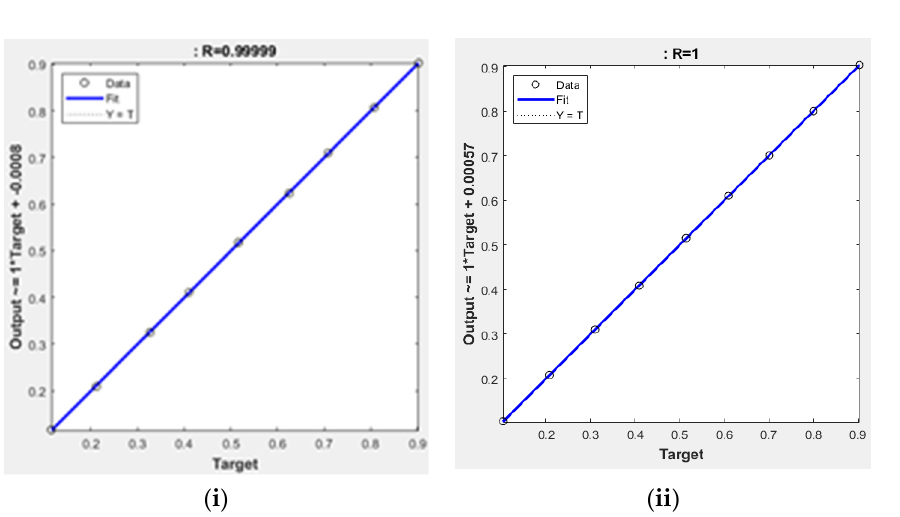
Table 8. Statistical parameters for the simulated data of AN7-A and AN7-B.